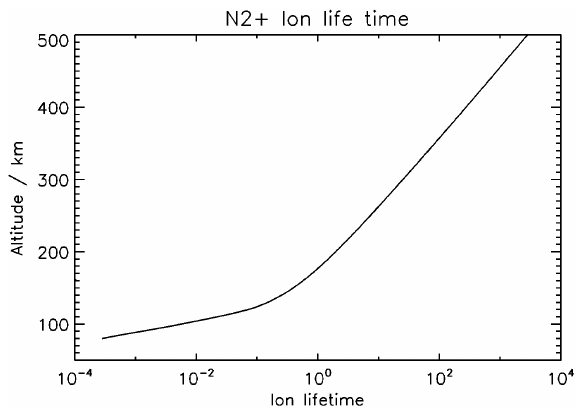
Fig. 5. Ion lifetime derived from the ion chemistry model using the MSIS atmospheric thermal model for a typical atmosphere at 07:00 UT in January over Svalbard with A p index of 7 and solar radio flux f107av of